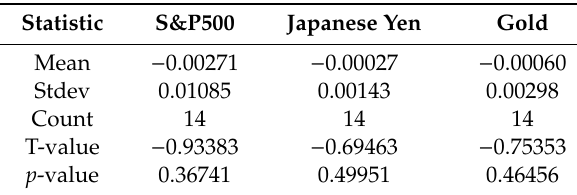
Table A9. ($) h T ’s HE − ($) h c ’s